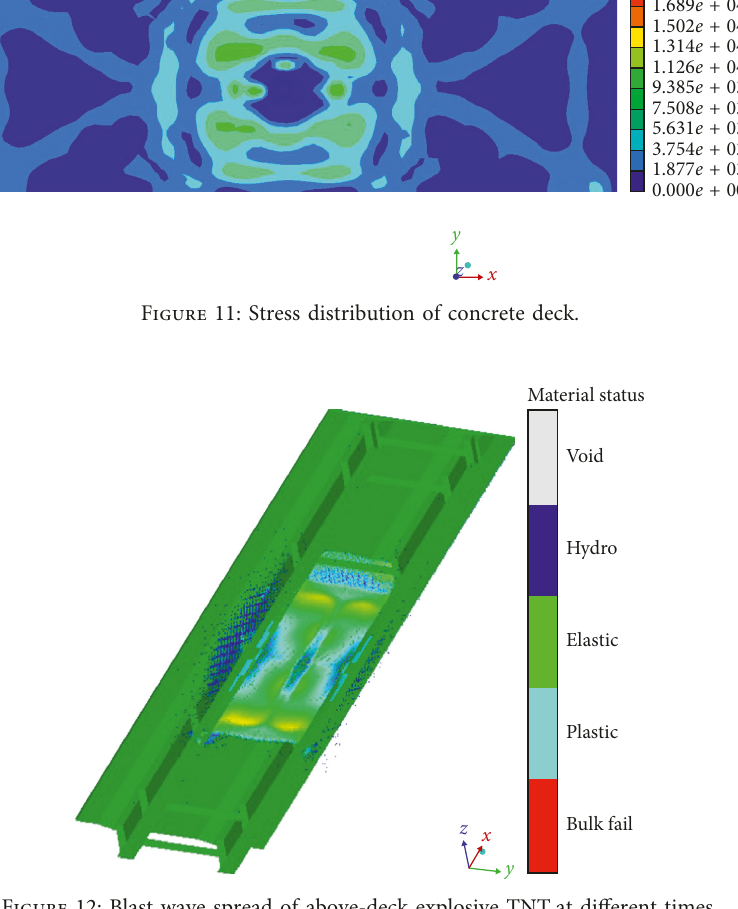
Figure 12: Blast wave spread of above-deck explosive TNT at different times.